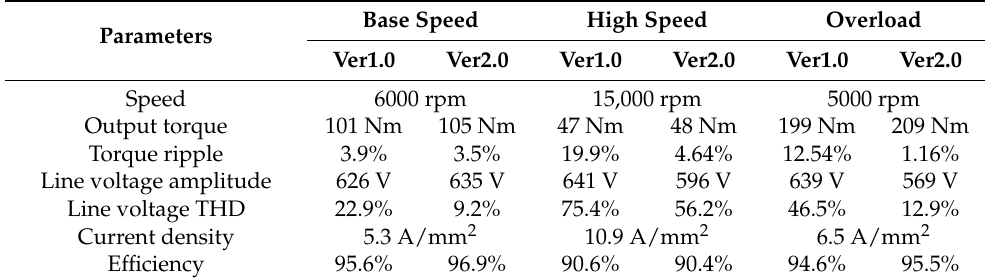
Table 8. Ver2.0 motor and Ver1.0 motor electromagnetic